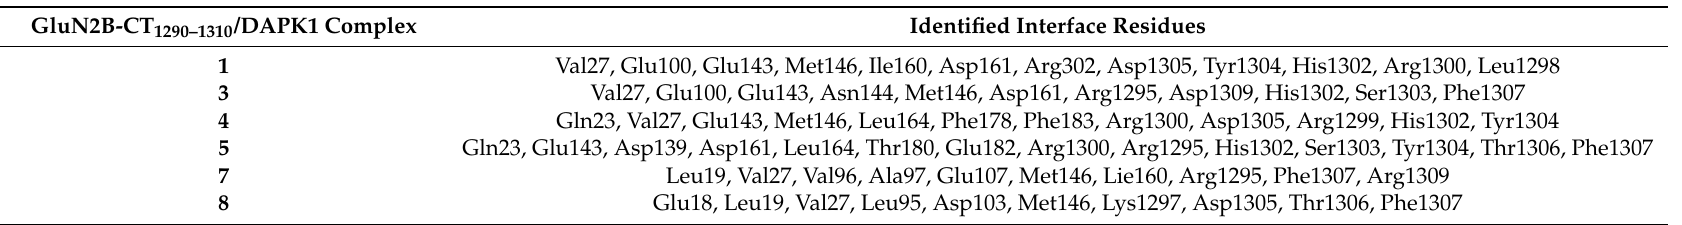
Table 4. Summary of the identified interface residues shown to contribute to GluN2B-CT 1290–1310 /DAPK1 binding in the six analyzed simulation